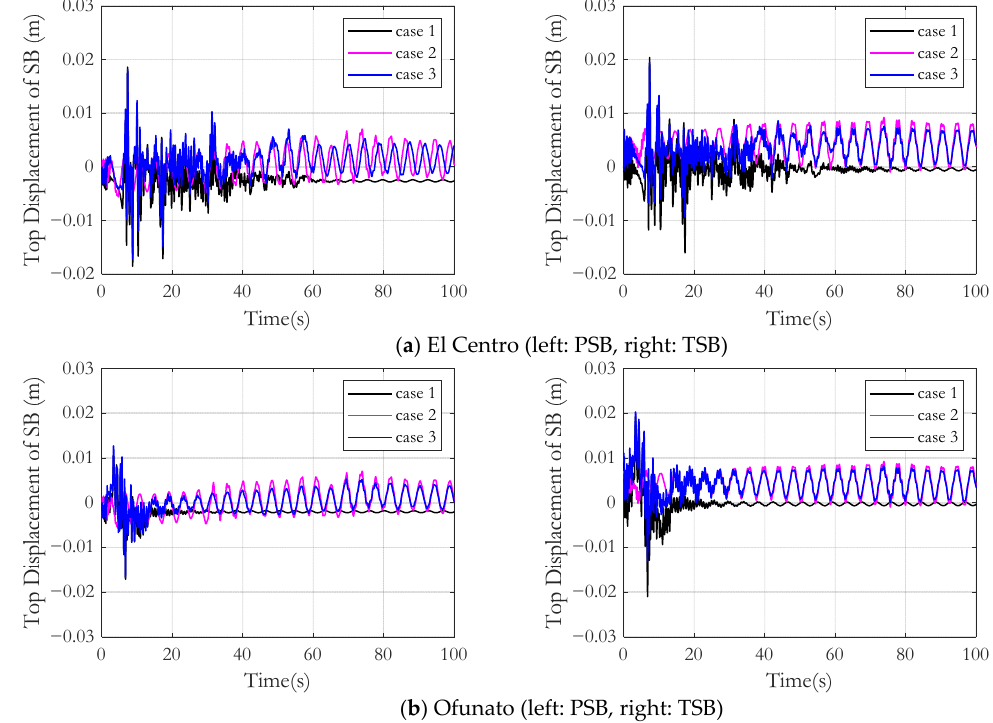
Figure 21. Top displacement of SB under joint action of seismic–wind combination and scour condition.